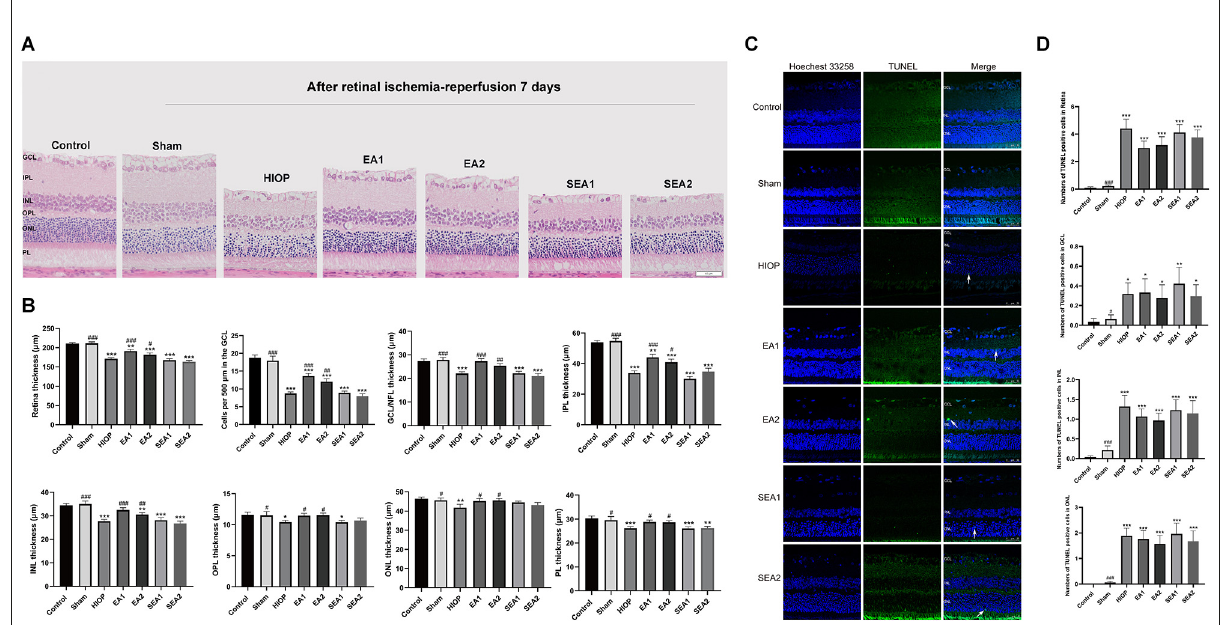
FIGURE7 EA can ameliorate injury and apoptosis of the retina at 7 days of RIRI in rats. (A) H&E staining of retinal cross-sections showing the retinal tissue thickness of every group of RIRI rats at 7 days. GCL, ganglion cell layer; INL, inner nuclear layer; IPL, inner plexiform layer; ONL, outer nuclear layer; OPL, outer plexiform layer; PL, photoreceptor layer (scale bar: 50 µ m). (B) Measurement of retinal thickness from the ganglion cell layer (GCL) to the photoreceptor layer (PL); the number of cells per 500 µ m in the GCL and the mean thicknesses of different retinal layers after RIRI for 7 days in rats are shown. (C) Apoptotic cells were detected by TUNEL assay in retinal sections after RIRI for 7 days in rats. Representative images of TUNEL-positive cells (green) are shown. The nuclei were counterstained with Hoechst 33342 (blue). Scale bar: 50 µ m. (D) Bar graphs showing the average numbers of TUNEL-positive cells in the GCL, ONL, INL, and entire retina. The data are presented as the mean ± SEM (* P < 0.05, ** P < 0.01, *** P < 0.001 vs. the control group; # P < 0.05, ## P < 0.01, ### P < 0.001 vs. the HIOP group; n = 5 for each